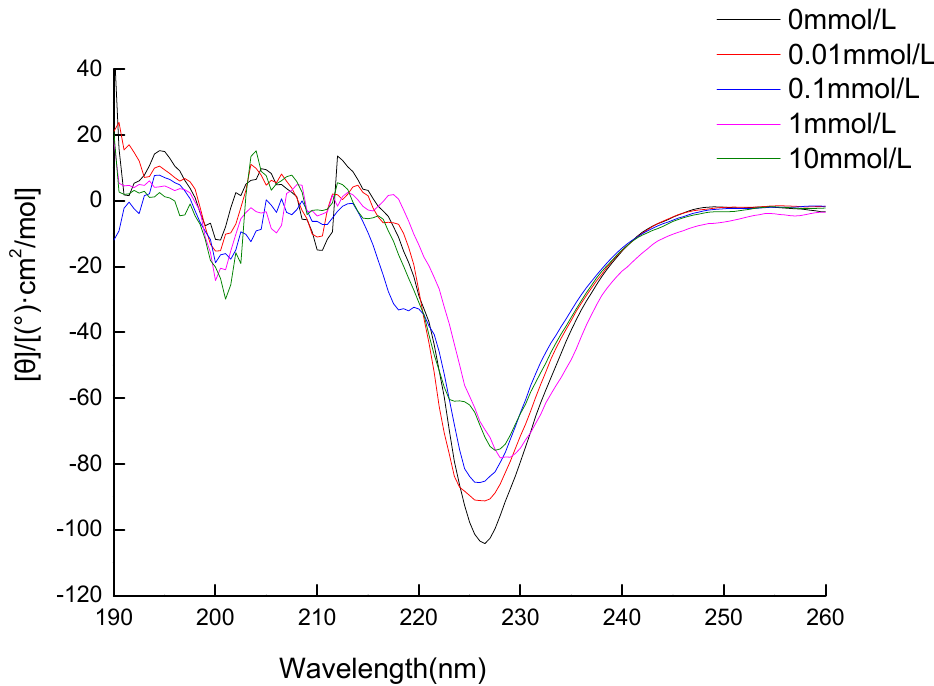
Figure 1. Circular dichroism spectra of walnut protein incubated with different concentrations of MDA (0 mM; 0.01 mM; 0.1 mM; 1 mM; and 10 mM).